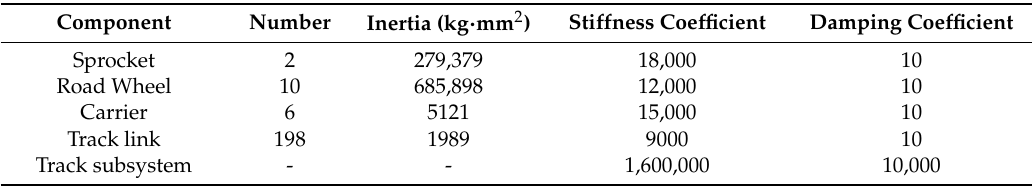
Table 9. Dynamic simulation parameters.